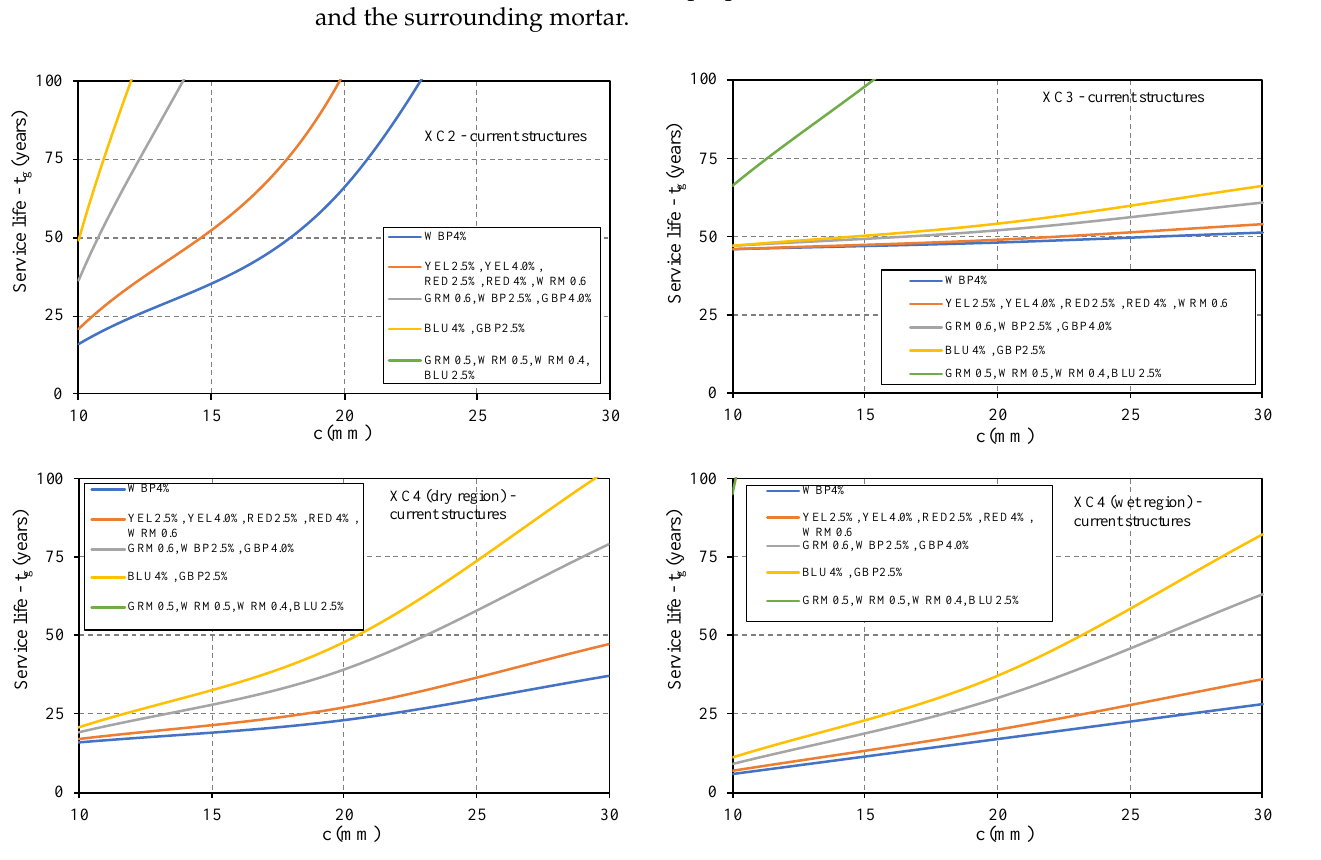
Figure 10. Prediction of the service life for current structures, classes XC.